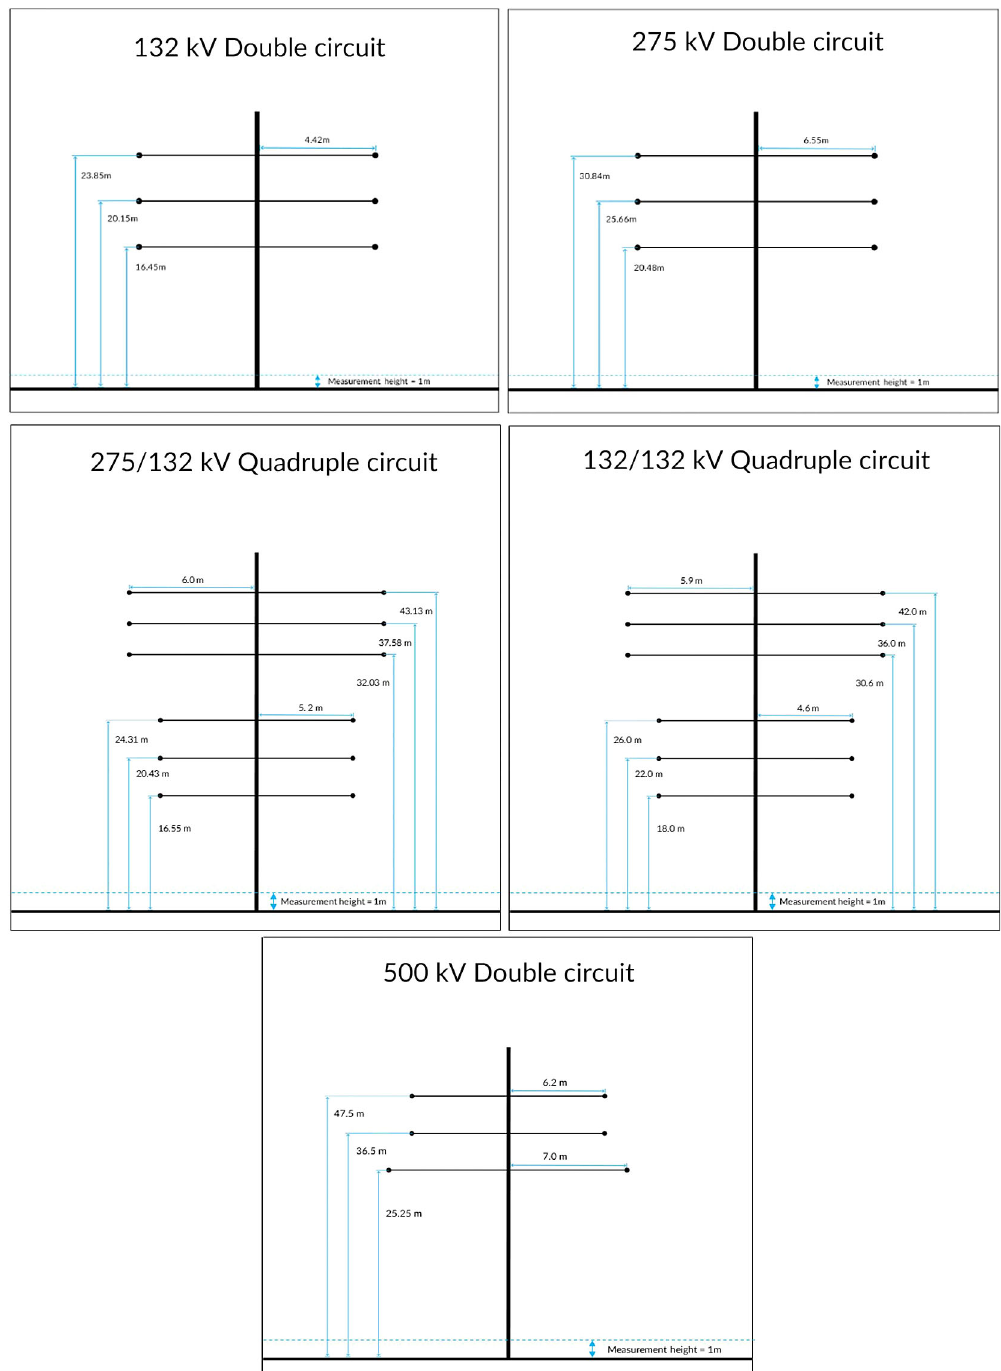
Figure 1. Overhead power transmission lines towers in Malaysia. 4-6,10,11